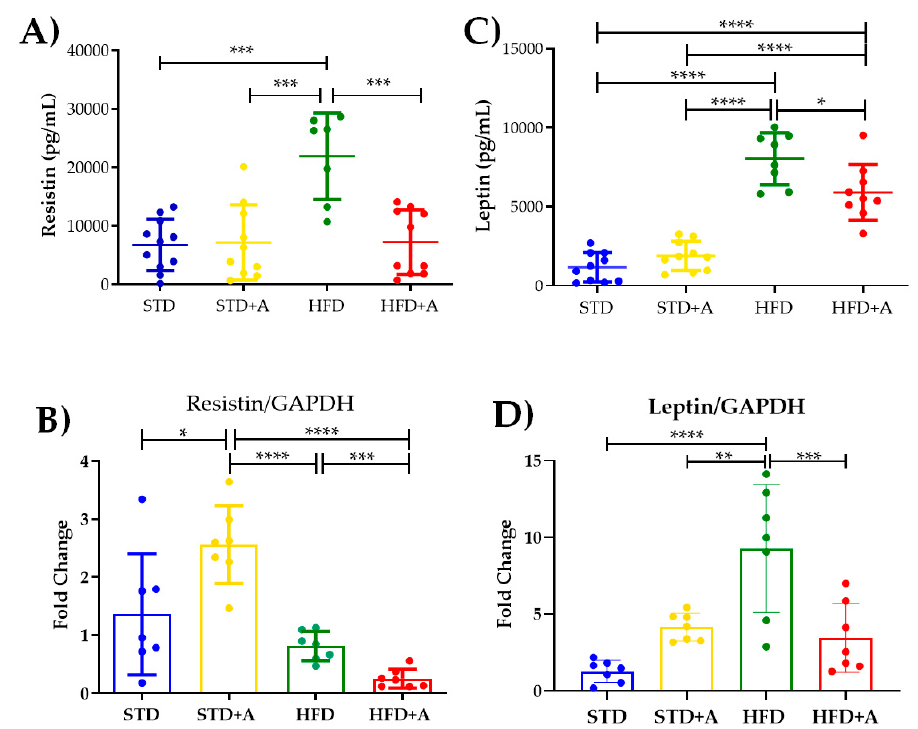
Figure 5. E ff ect on secretion and expression of adipocytokines. ( A ) The e ff ect of alliin in resistin secretion was notably significant between the HFD and the HFD + A groups (*** p < 0.001). ( B ) This di ff erence was also observed in the gene expression of resistin (*** p < 0.001). ( C ) Similar behavior was shown in leptin serum levels in the HFD + A group (* p < 0.05), ( D ) a di ff erence that persisted in the gene expression of leptin (** p < 0.01, *** p < 0.001, **** p < 0.0001). STD, standard diet group; STD + A, standard diet + alliin treatment group; HFD, high-fat diet group; HFD + A, high-fat diet + alliin treatment group. Adipocytokine serum levels were analyzed by one-way ANOVA / Tukey’s test. For gene expression, each sample 2 - ∆∆ CT was calculated and analyzed by one-way ANOVA / Tukey’s test, except for resistin gene expression, where Student’s T test was performed. Values shown as mean ±